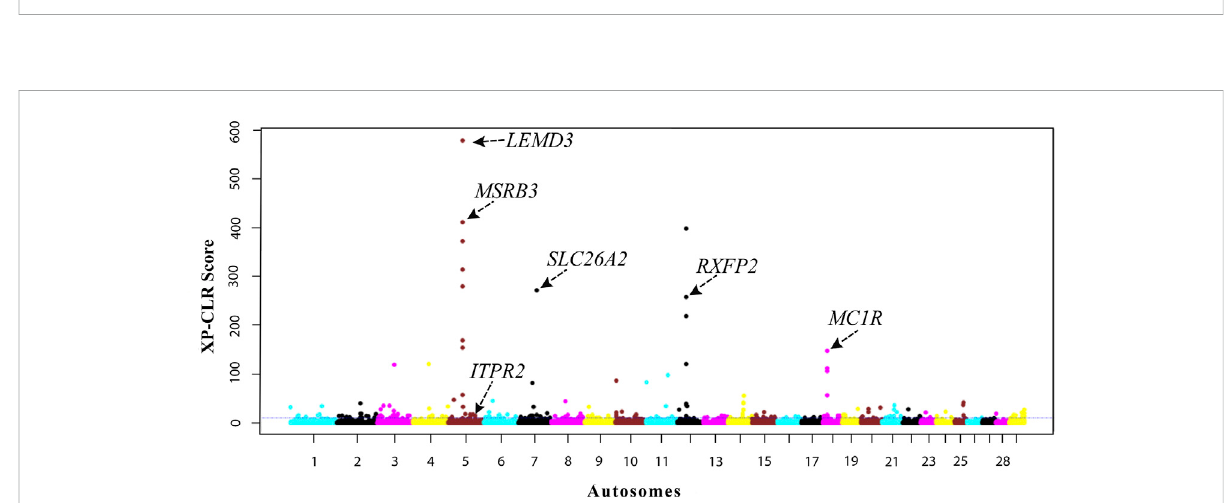
FIGURE 5 Manhattan plot of genome-wide XP-CLR scores by contrasting the high- and low-altitude cattle